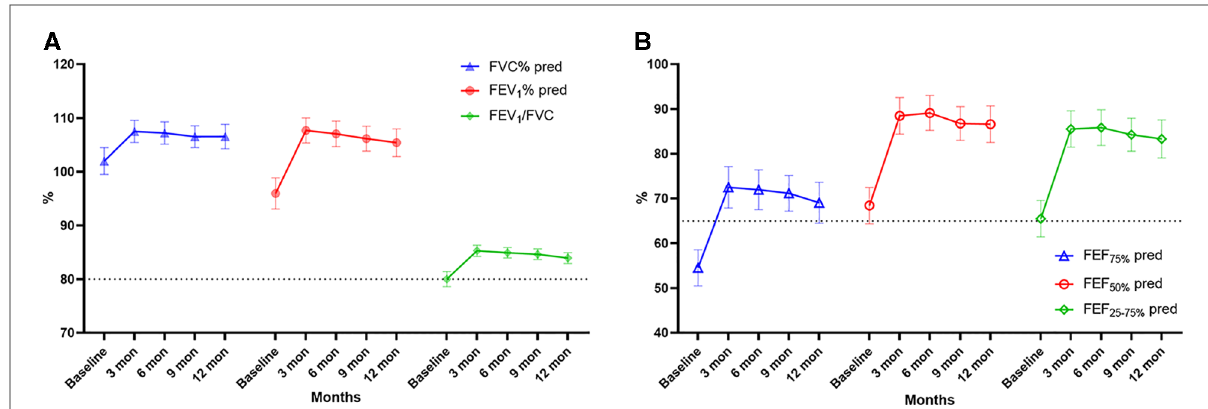
FIGURE 3 Large ( A : FVC%, FEV 1 , FEV 1 /FVC) and small ( B : FEF 75% , FEF 50% , FEF 25 – 75% ) airway function parameters over time. FVC, forced vital capacity; FEV 1 , forced expiratory volume in 1s, FEF 75% , forced expiratory fl ow at 75% of forced vital capacity; FEF 50% , forced expiratory fl ow at 50% of forced vital capacity;